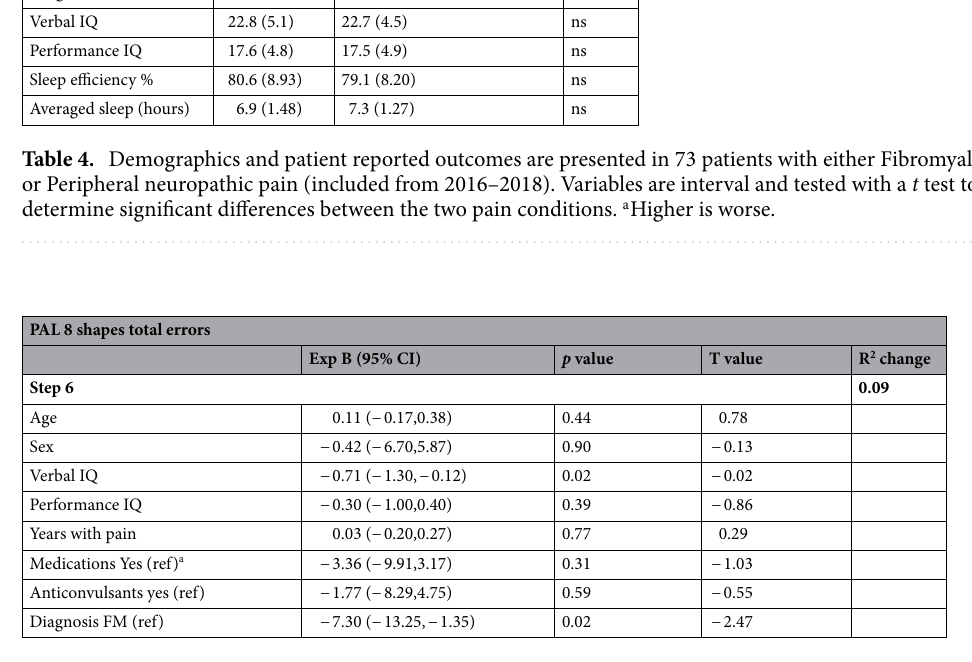
Table 5. The executive functioning outcome PAL analyzed using a multivariate linear regression model. The condition category and its association with this outcome were controlled for age, sex, IQ and all other variables showing significant differences between categories. These variables were then added in steps to investigate r 2 change per step. The final step, step 6, shows all variables in the model and how they affect the chosen outcome, as well as r 2 from adding condition category. a Anticonvulsants, antidepressants or opioids.